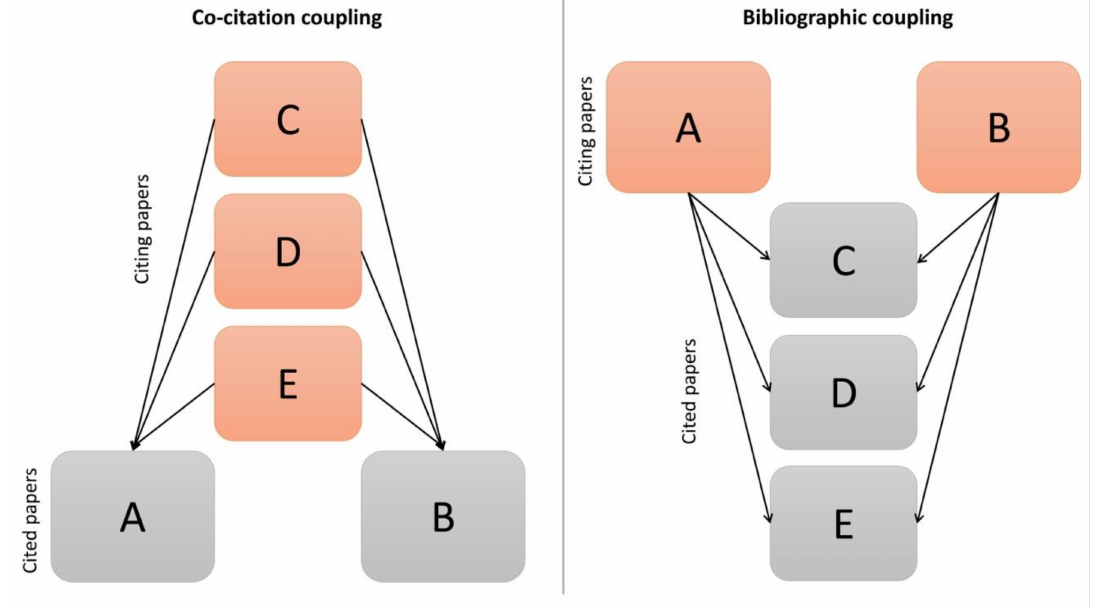
Figure 1. Bibliographic and co-citation coupling